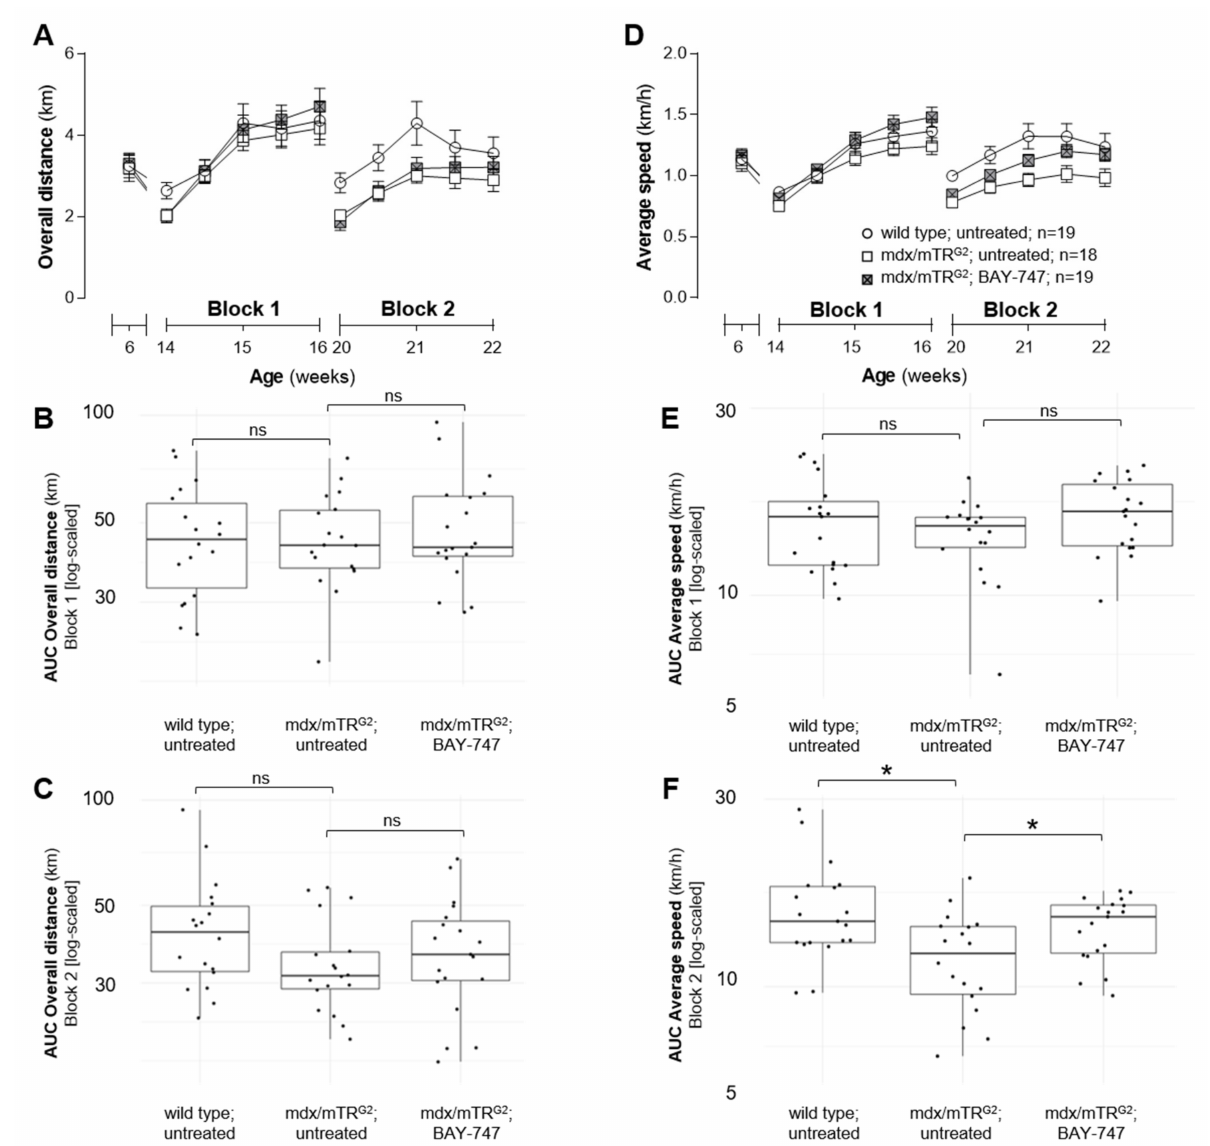
Figure 4. Treatment with BAY-747 improved speed but not the overall distance run by mdx/mTR G2 mice in the running wheel functional assessment. In the voluntary running wheel assessment, mice treated with BAY-747 run the same overall distance ( A ) but at a faster average speed ( D ) than untreated mdx/mTR G2 mice. AUC was calculated for each mouse and log-transformed for Blocks 1 and 2 for overall distance ( B , C ) and average speed ( E , F ), respectively. * p < 0.05; ns, not significant. For statistical analysis method, please refer to the Materials and Methods